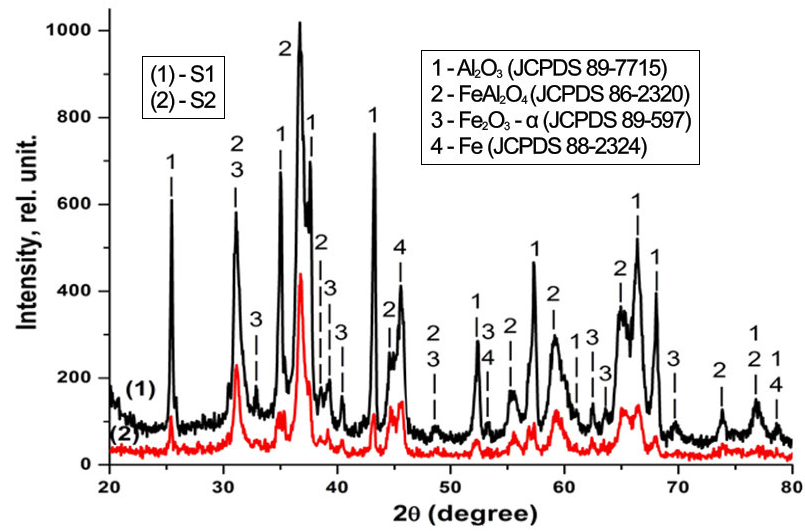
Figure 3. XRD patterns of PEO coatings formed in 25g/l NaAlO 2 electrolyte.